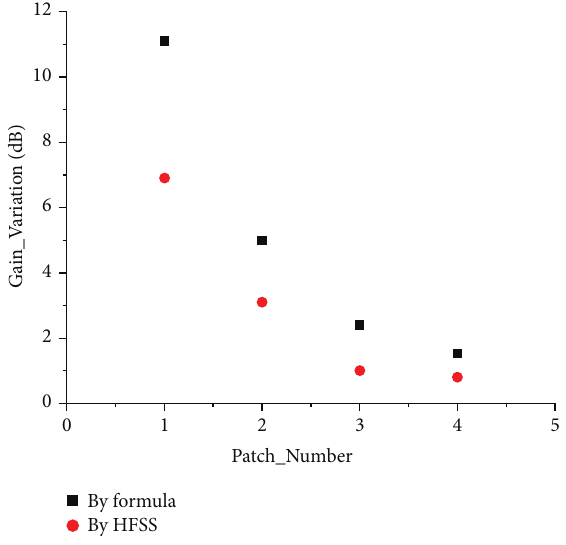
Figure 7: Gain variation difference in 𝑦 - 𝑧 plane.